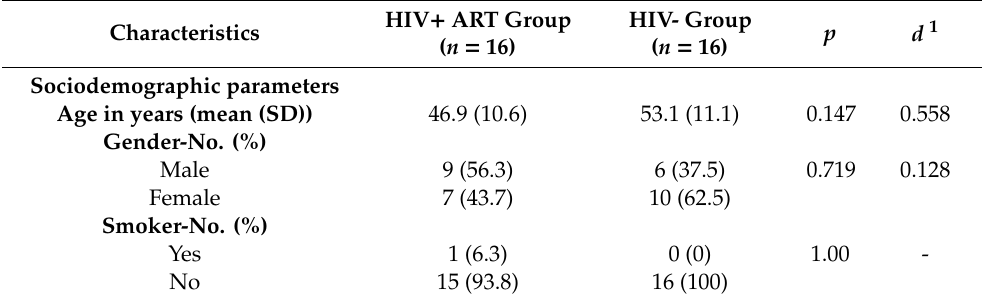
Table 1. Sociodemographic and behavioral characteristics related to the groups studied. ART: antiretroviral